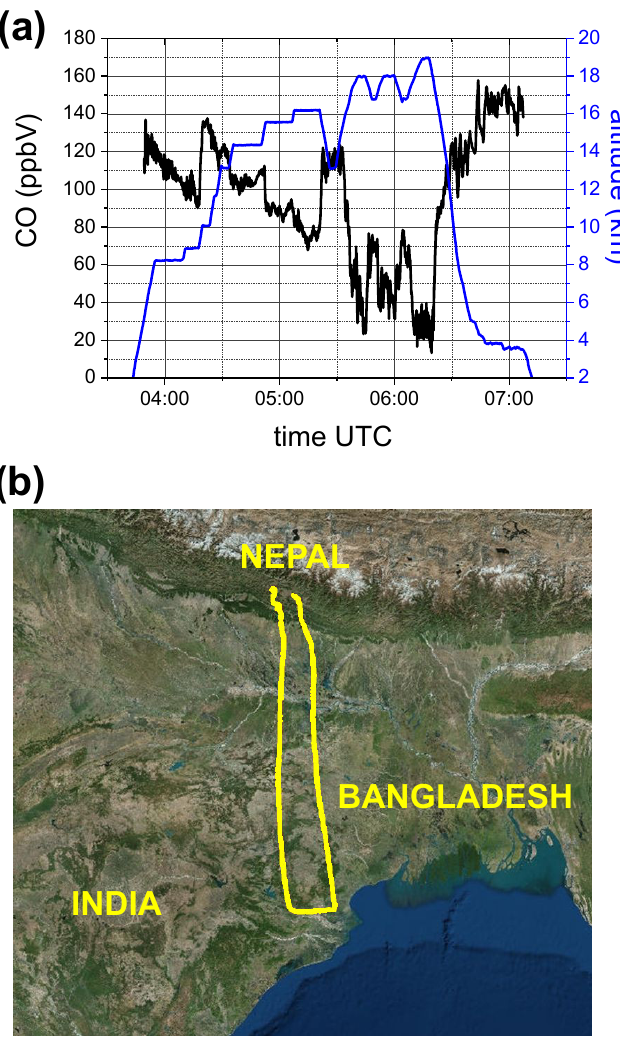
Figure 11. ( a ) COLD2 results on board the M55 stratospheric aircraft during the flight on the 8th August 2017 of the StratoClim campaign from Katmandu (Nepal). CO mixing ratio (black line) and aircraft altitude (blue line) vs UTC time. ( b ) map of the M55